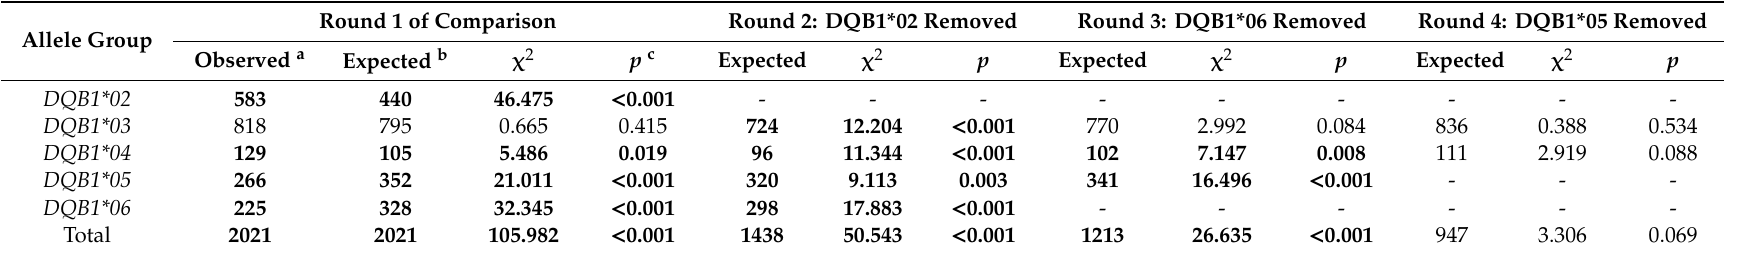
Table 4. Relative Predispositional E ff ects (RPEs) of HLA-DQB1 allele groups on